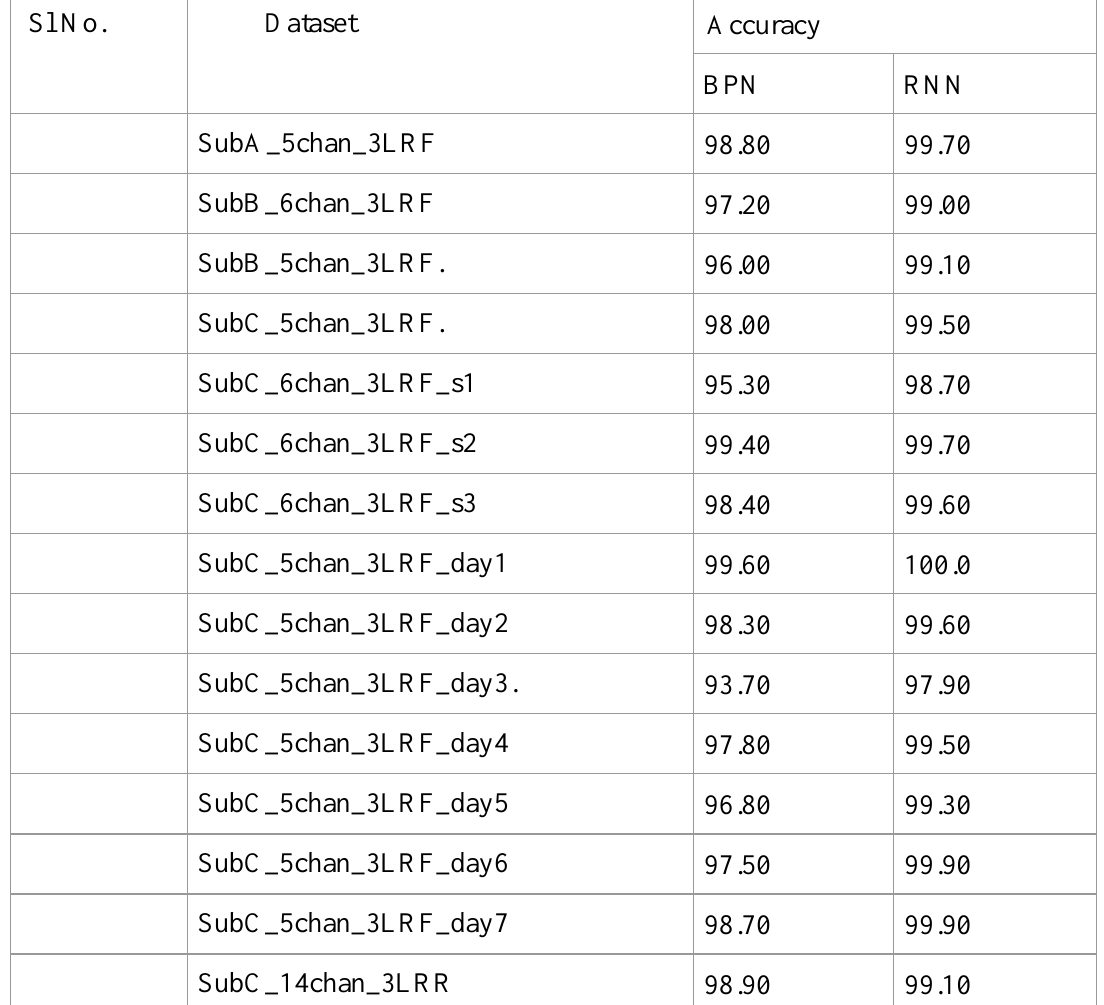
Table 2: Classification accuracy of three class data sets by BPN and